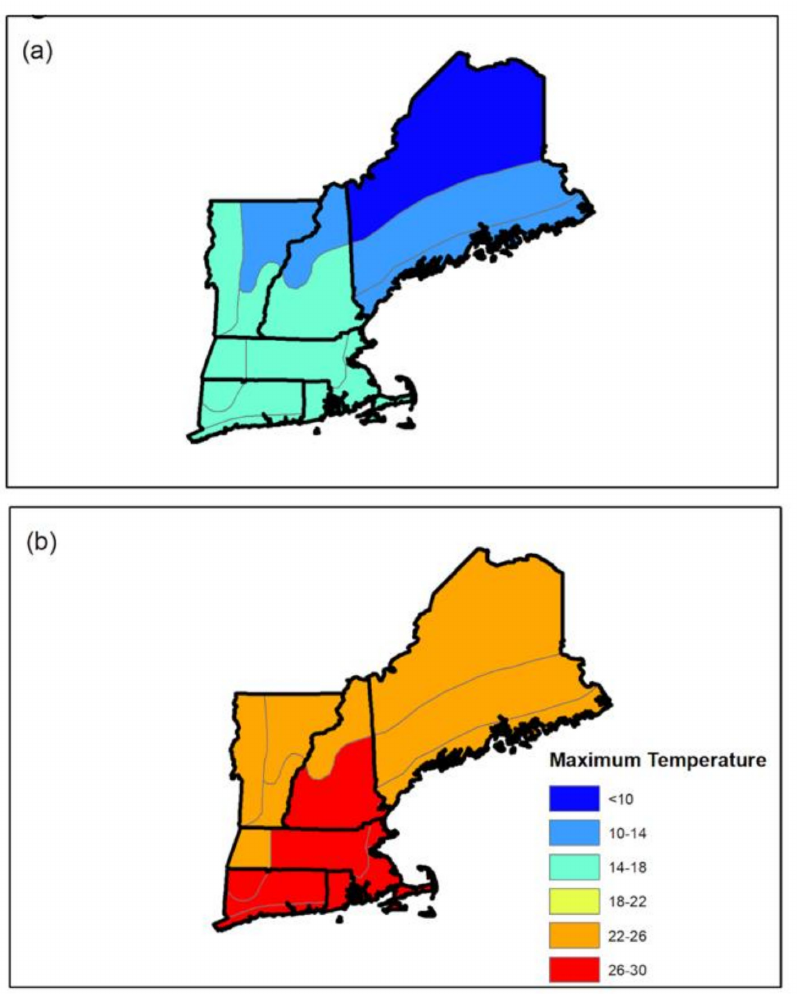
Figure 2. ( a ) Average maximum monthly ambient temperature in New England by climate division for April–May (baseline; unacclimatized) in 2019 and ( b ) average maximum monthly ambient temperature in New England by climate division for June–August (heat acclimatization) in